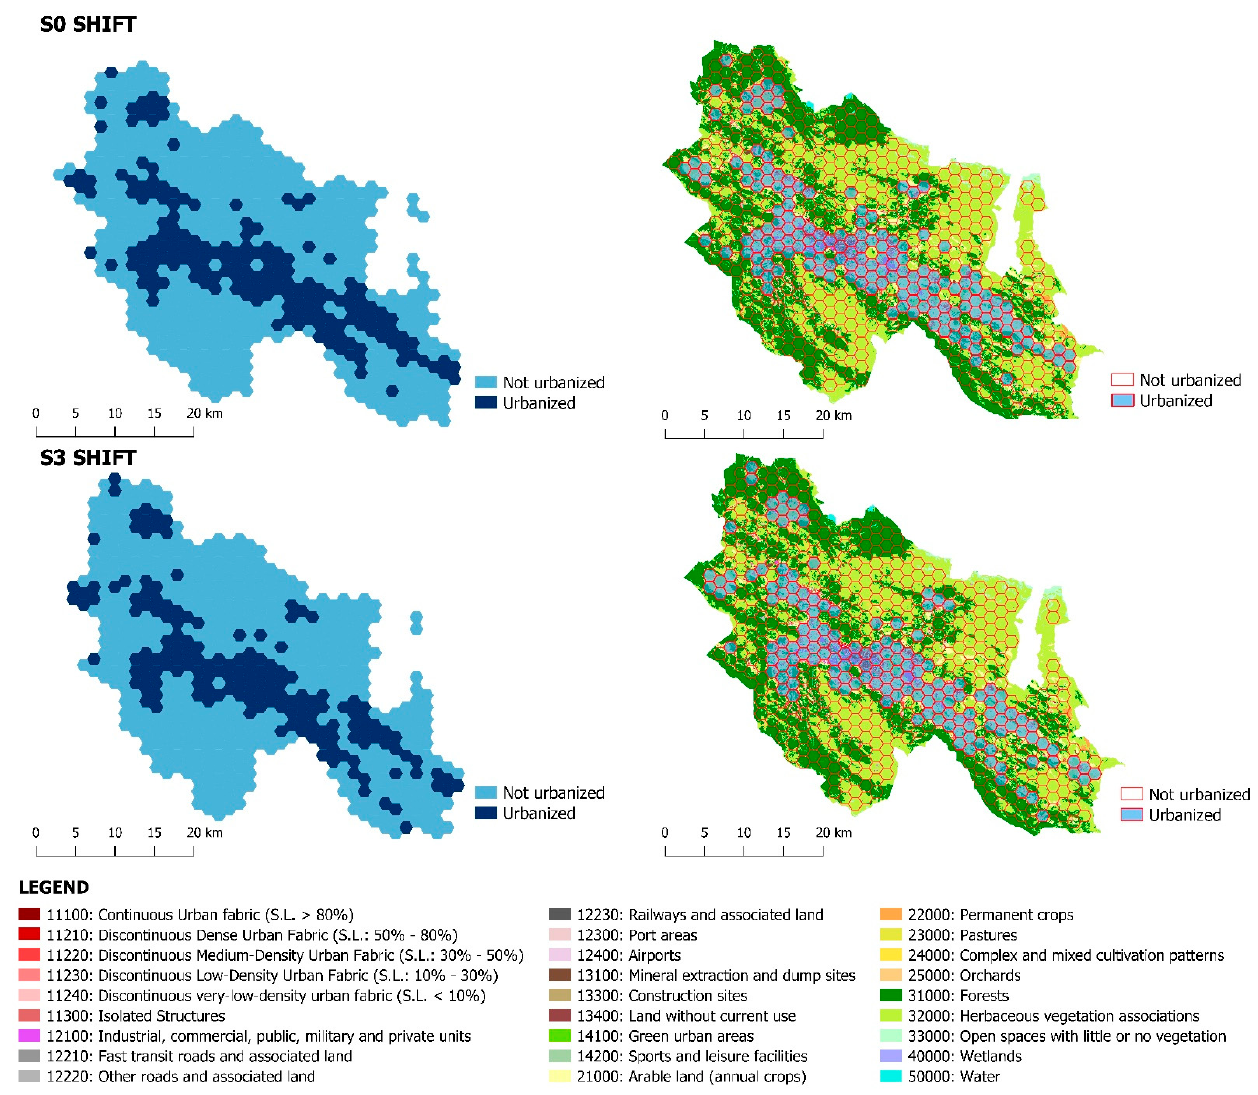
Figure 6. K—Means S 0 and S 3 grid shift classifications using the five main classes from the Urban Atlas dataset.